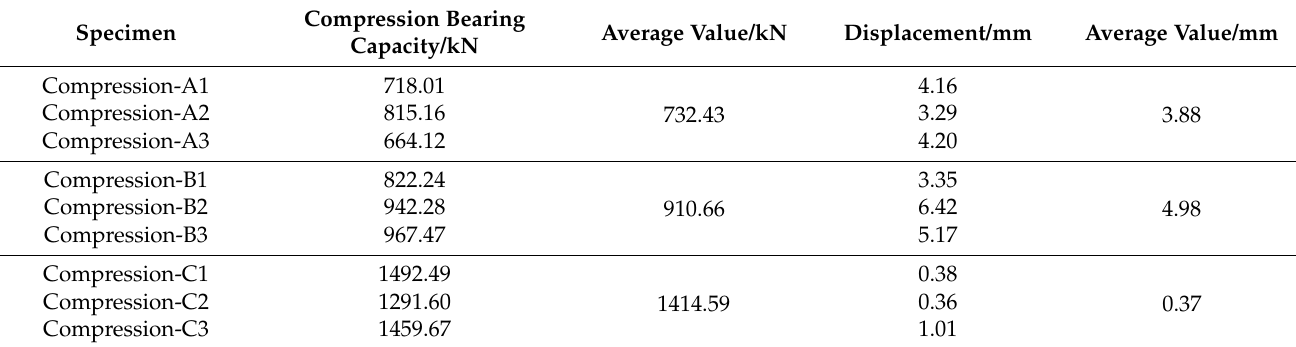
Table 2. The results of the compression tests.